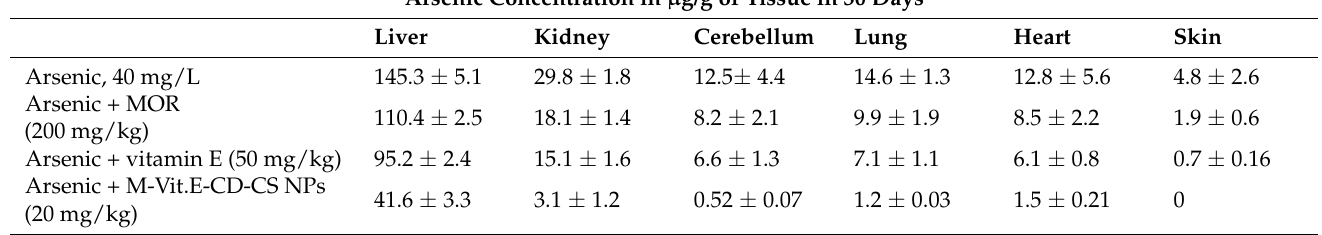
Table 2. Arsenic deposition in different